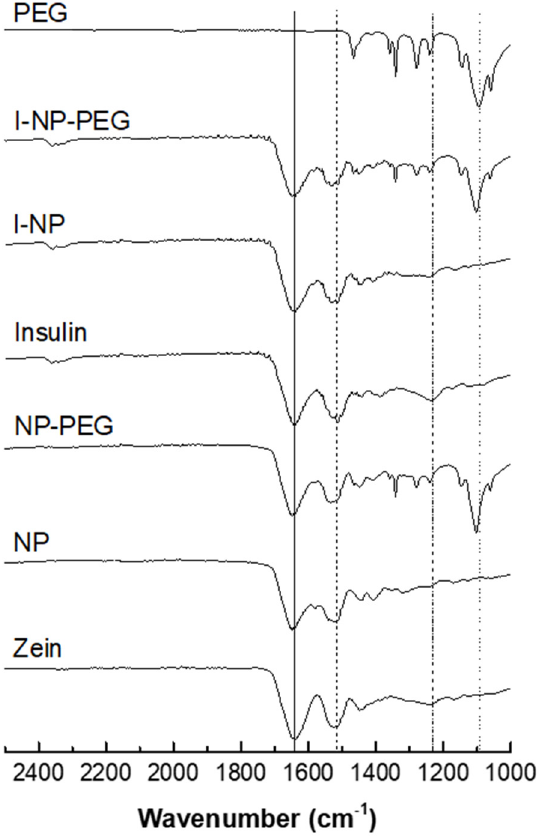
Figure 3. FTIR spectra of PEG 35,000, zein, insulin, empty zein nanoparticles uncoated (NP) and coated with PEG (NP-PEG), and insulin-loaded nanoparticles with (I-NP-PEG) and without PEG coating (I-NP). Straight line corresponds to the 1647 cm − 1 band belonging to the amide I group; dashed line corresponds to the 1517 cm − 1 band belonging to the amide II group; dashed-dotted line corresponds to the 1236 cm − 1 band belonging to the amide III group; dotted line corresponds to the 1096 cm − 1 band belonging to the alcoholic group of